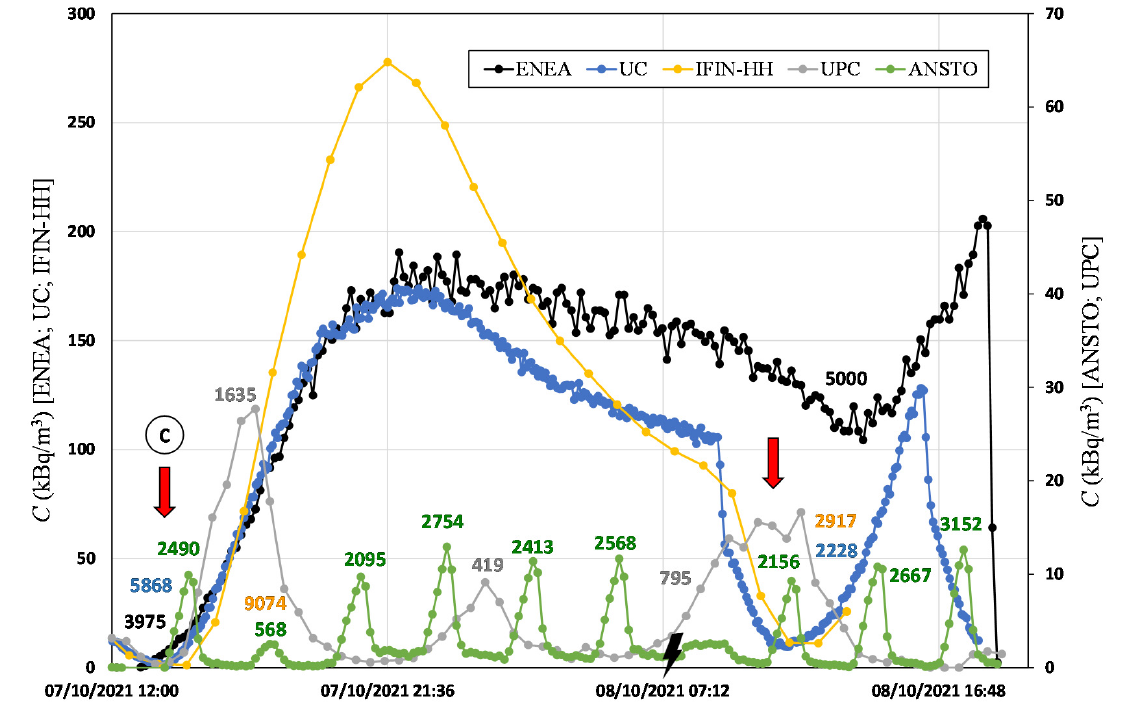
Figure 10. Radon activity concentration over time measured after the static accumulation period. Number labels indicate the radon flux (Bq m − 2 h − 1 ) calculated by linear fitting. Table 5. Mean radon flux E obtained from the average of n number of measurements carried out in the high radon flux area campaign considering a time period T in the linear fit and the standard deviation SD of the